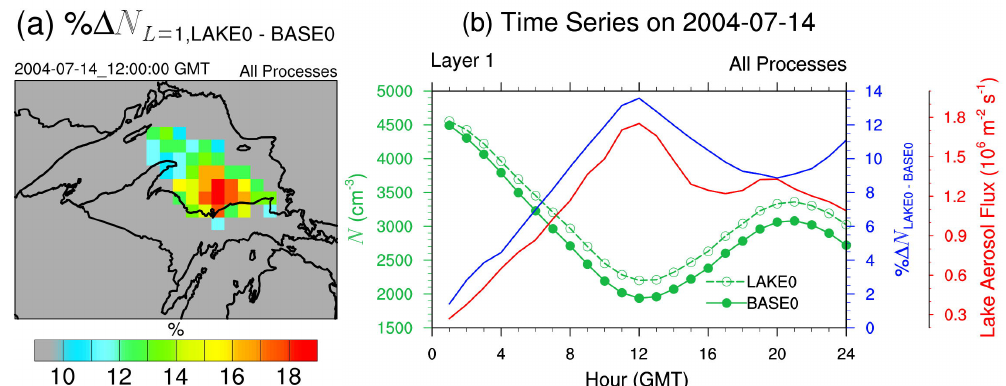
Fig. 4. (a) Same as Fig. 3c but focusing on the Lake Superior region and highlighting grid cells in which the percent difference is greater than 10%; (b) hourly results for 4 July 2004 for the region highlighted in (a) . Results shown include the total surface-layer aerosol number concentration N for BASE0 and LAKE0, the percent difference between them when all aerosol dynamical processes are included, and wind-generated lake surface aerosol number